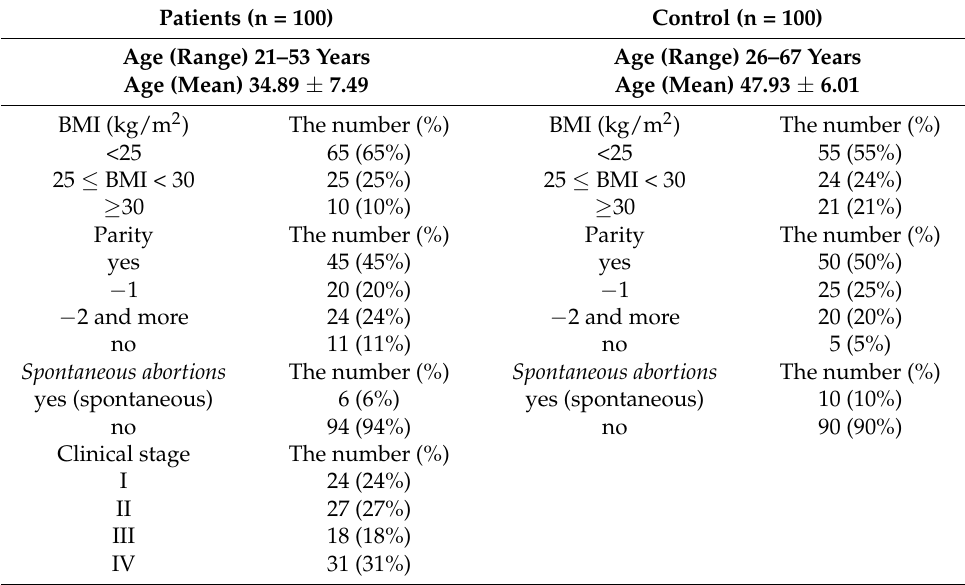
Table 1. Clinical–pathological characteristics of the study